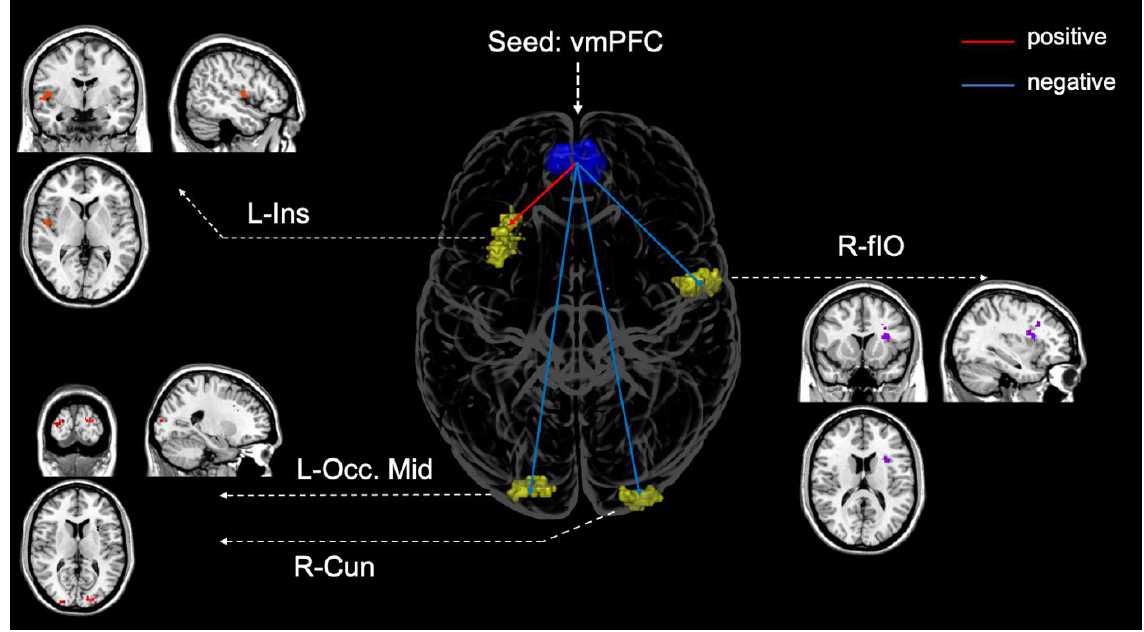
Figure 5. Seed-to-voxel functional connectivity with the vmPFC seed (FDR-corrected at cluster-level with p < 0.05, p < 0.001 uncorrected height threshold, and 30 voxels extended threshold). Red: Positive connectivity, blue: Negative connectivity.